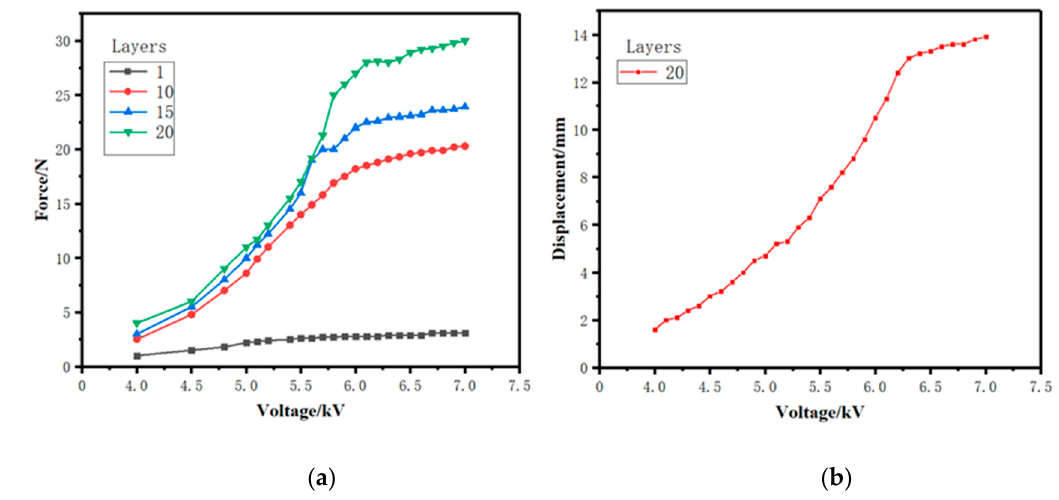
Figure 10. ( a ) The output forces of the 1-layer, 10-layer, 15-layer, and 20-layer DEAs at 4–7kV. ( b ) The displacement of the 20-layer DEA at 4–7kV.